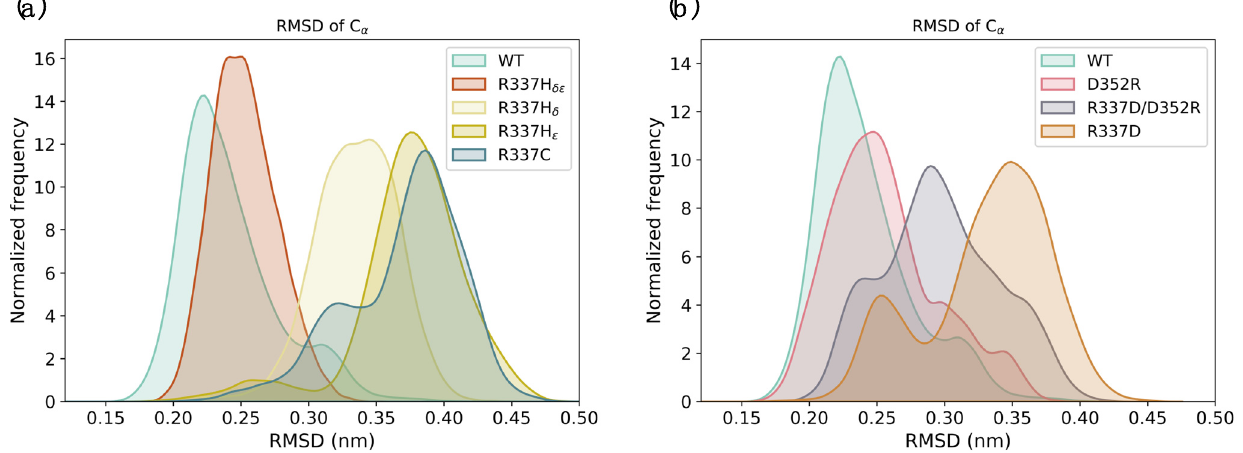
Figure 2. Molecular dynamics simulations of p53 TET domain mutants. ( a ) The destabilization effect of disease-associated mutations lying within the p53 TET domain was analyzed by molecular dynamics. The graph shows the RMSD distribution of the WT tetramer and the R337C and R337H mutants. The latter was simulated in three different states of the histidine including the protonation of δ (R337H δ ), ε (R337H ε ), or both (R337H δε ) nitrogens. The results indicate that the WT and R337H δε showed overlapping distributions with low RMSD values. Conversely, the R337H δ , R337H ε , and R337C mutants exhibited distributions centered at higher RMSD values. ( b ) The effect of rationally designed substitutions, including D352R, R337D, and R337D/D352R, on the stability of the p53 TET domain was compared to the WT counterpart. The results indicate that the WT and the D352R form showed distributions with low RMSD values. Conversely, the R337D/D352R and R337D exhibited distributions centered at higher RMSD values, with the latter presenting a more prominent destabilization. Each system was simulated for 2 µs.